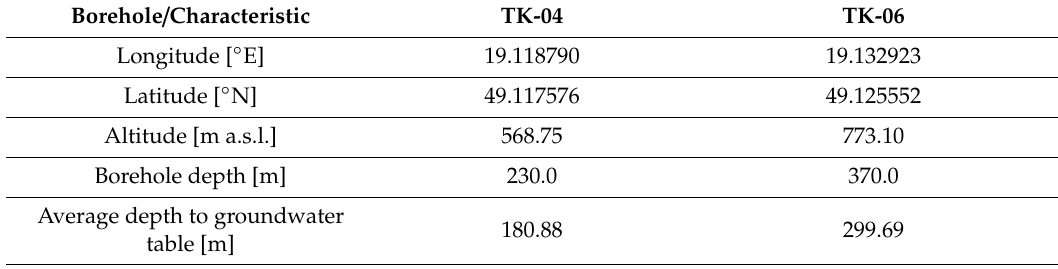
Table 2. Characteristics of TK-04 and TK-06 boreholes in the Kopa Mt. hydrogeological